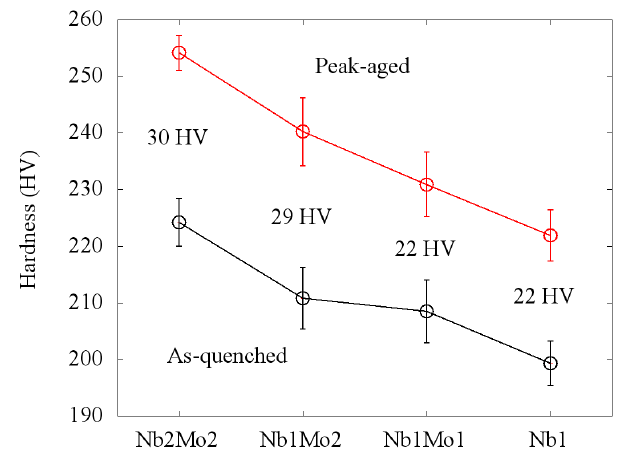
Figure 4. As-quenched, peak-aged, and associated precipitation hardness for the four investigated steels.